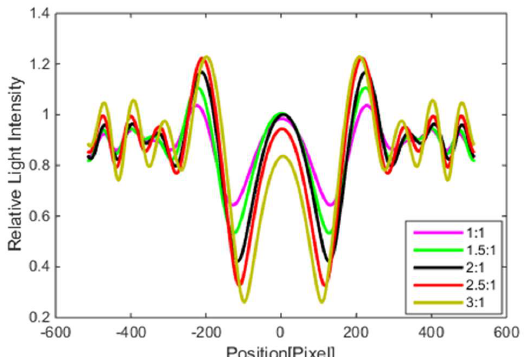
Figure 9. The light intensity value profile of the calculated spore diffraction fingerprint.